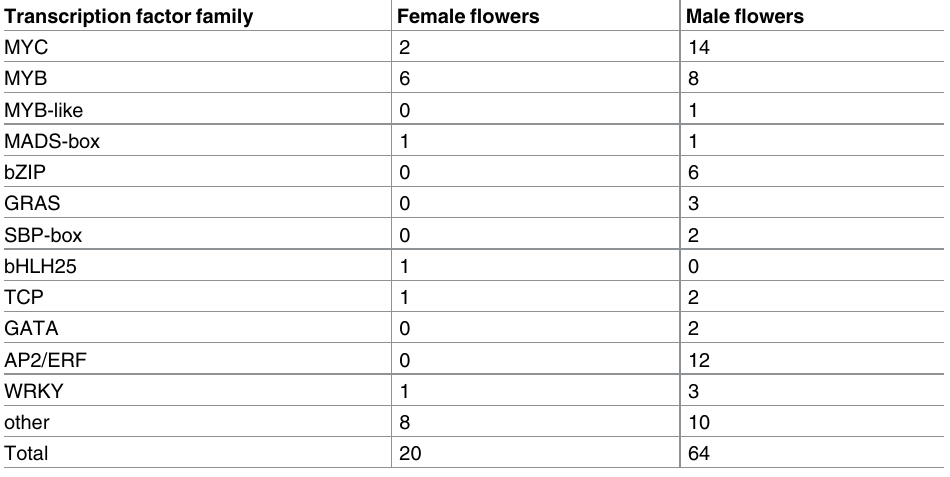
Table 2. Distribution of over-expressed transcription factors in female and male flowers.